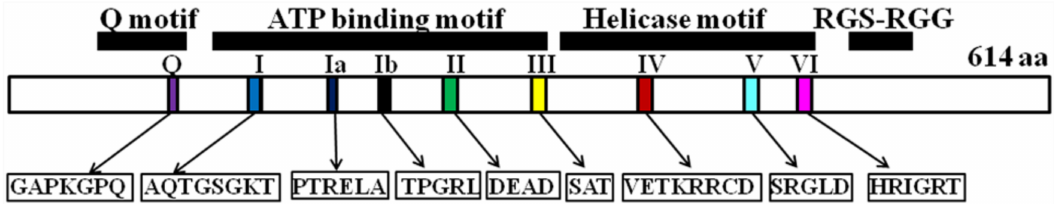
Figure 1. Scheme of DEAD-box polypeptide 5 (DDX5) core architecture and conserved motifs. A schematic representation of DDX5 showing its nine conserved motifs (Q, I, Ia, Ib, II, III, IV, V, and VI) and the corresponding conserved amino acid sequences of motifs are presented. RGS-RGG: